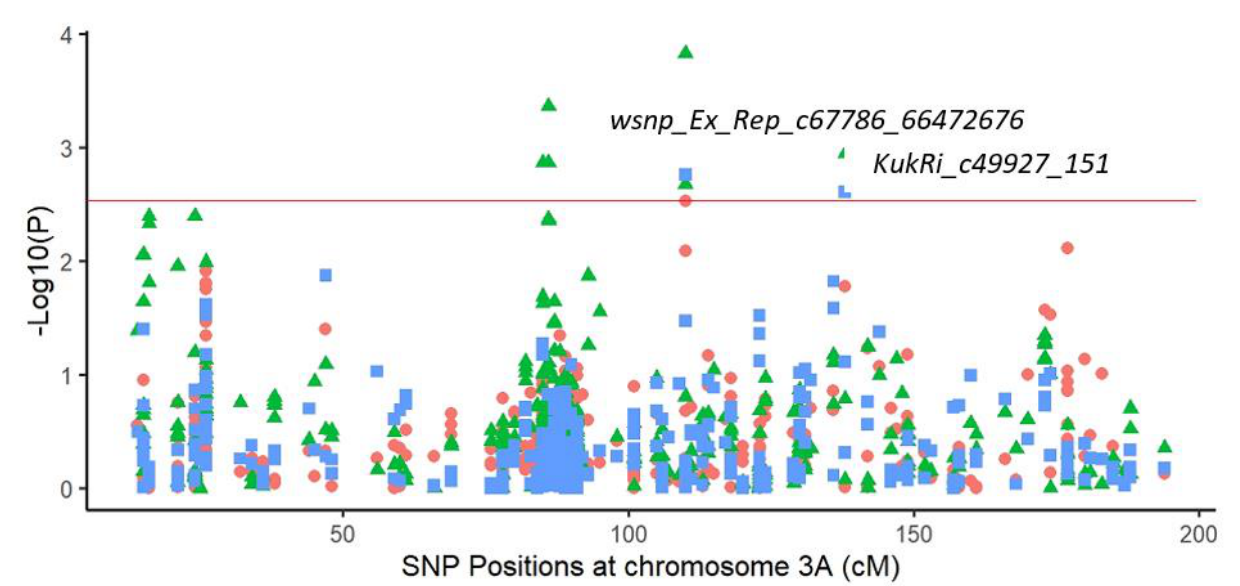
Figure 4. Genome-wide association study results using 425 single nucleotide polymorphism (SNP) markers on chromosome 3A in a 197 spring bread wheat population, showing pleiotropic effects for grain yield (square), biomass (dots) and ground cover (triangle) in the Sidi El Aidi station. The horizontal line shows the -log10 ( p ) = 2.5 threshold.